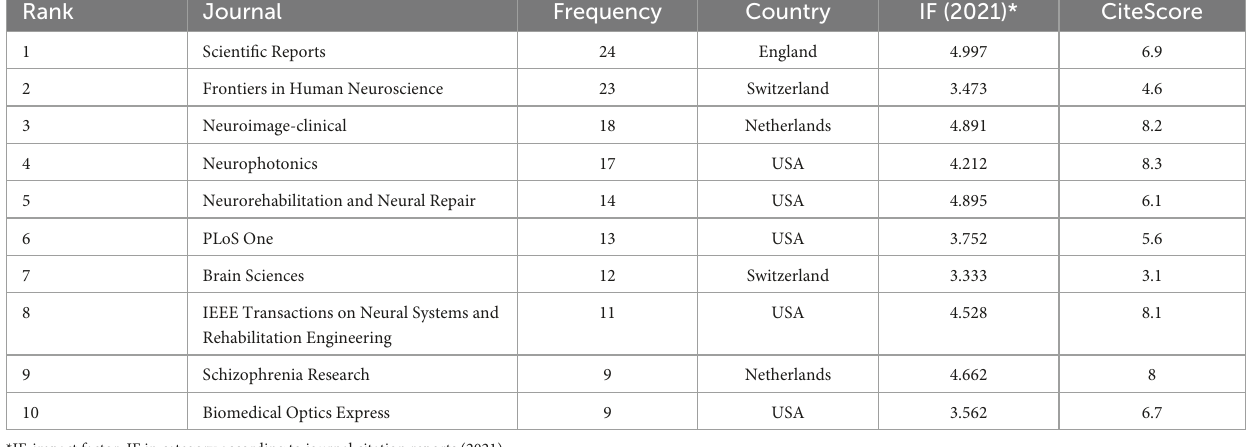
TABLE 1 The top 10 journals for functional near-infrared spectroscopy (fNIRS) research on diseases.